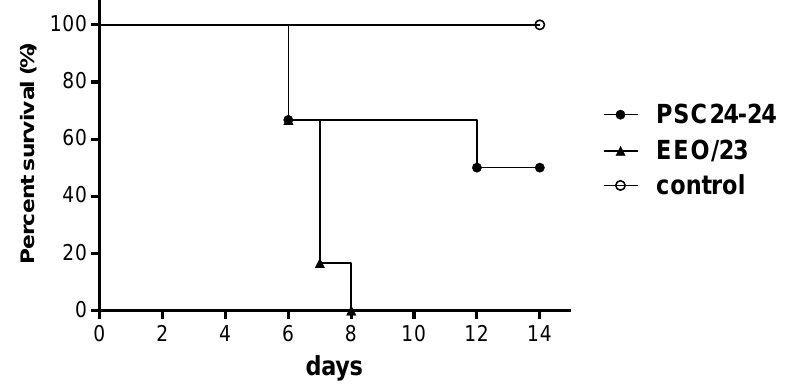
Figure 2. Survival curves of the experimentally inoculated ducks. Six 2-week-old ducks were inoculated with 10 6.0 EID /0.1 ml of A/mandarin duck/Korea/PSC24-24/2010 50 (PSC24-24) and A/Eurasian eagle owl/Korea/23/2010 (EEO/23), respectively. When comparing the survival curves of the two viruses, although they showed different mortality rates of 50% (PSC24-24) and 100% (EEO/23), there was no significant difference between the two viruses (log-rank test, p =